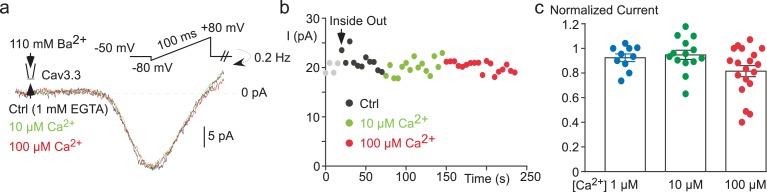
The effect of free Ca2+ application on the Cav3.3 current recorded in cell-free inside-out patches.(a) Effect of 10 µM and 100 µM Ca2+-containing solution on the Cav3.3 current recorded during voltage-ramp protocols in the inside-out patch configuration. (b) Time course of the Cav3.3 current during the experiment presented in (a). (c) Scatter plot and average effect of 1 µM, 10 µM and 100 µM Ca2+-containing solution (n = 10–19 per bar).